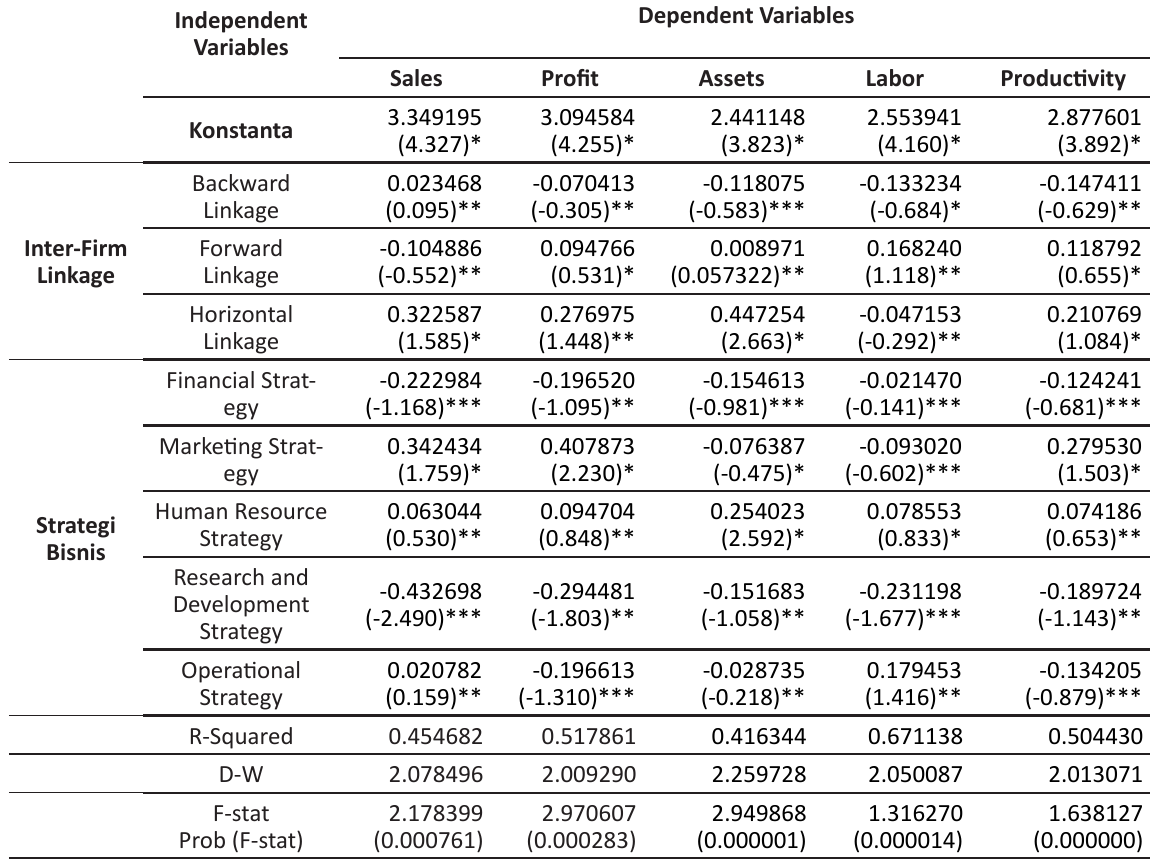
Table 3: Result of Multiple Linear